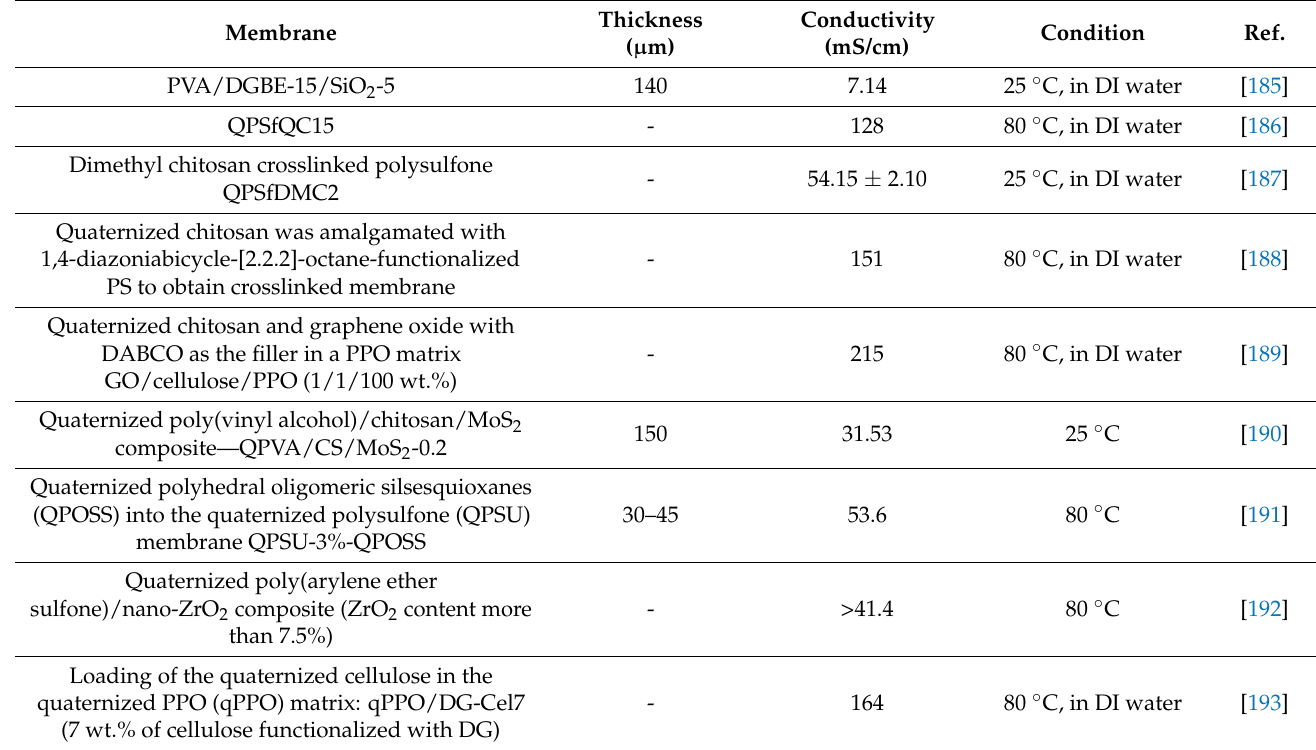
Table 10. Ionic conductivity of organic–inorganic-based